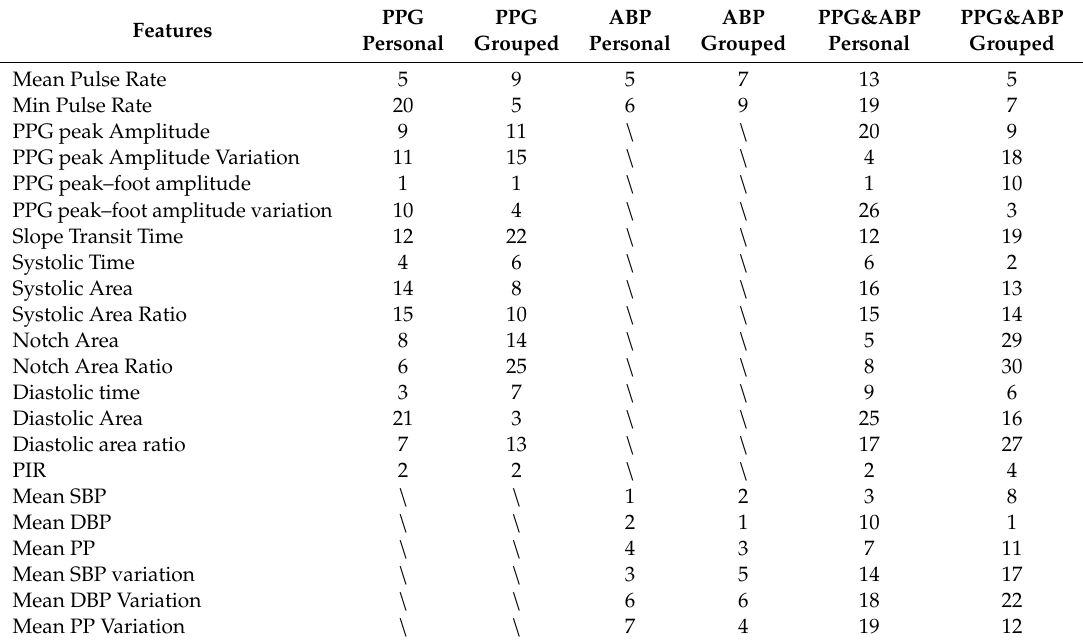
Table 3. Features’ importance ranking in the LASSO